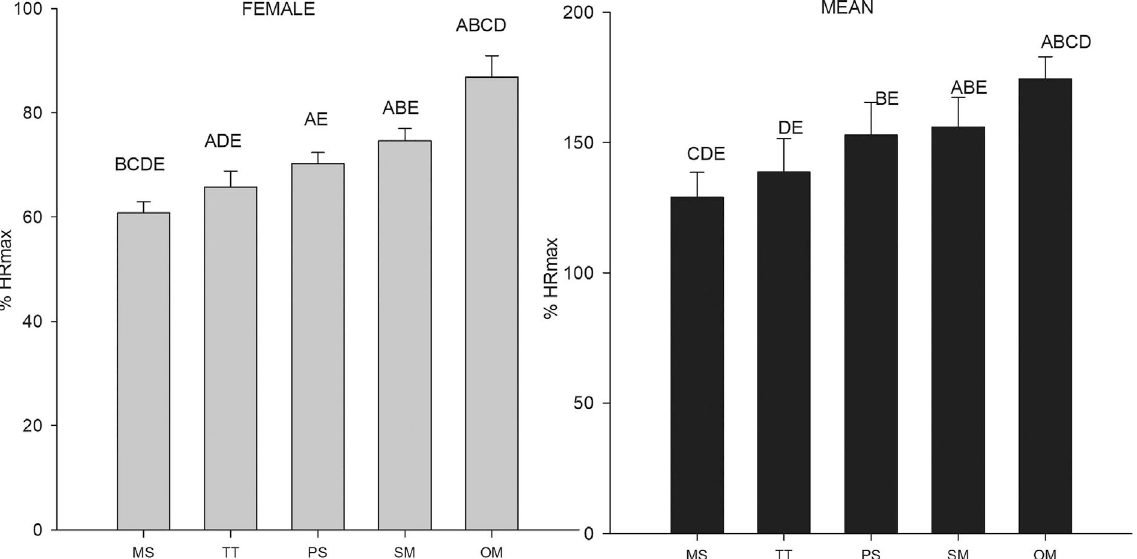
Figure 1 - %HRmax reached in in in the multi-shuttlecock, technical-tactical, physical, simulated match, and official match for the female and male ath- letes. A, significant difference compared to multi-shuttlecock; B, significant difference compared to technical-tactical; C, significant difference compared to physical; D, significant difference compared to simulated match (p <